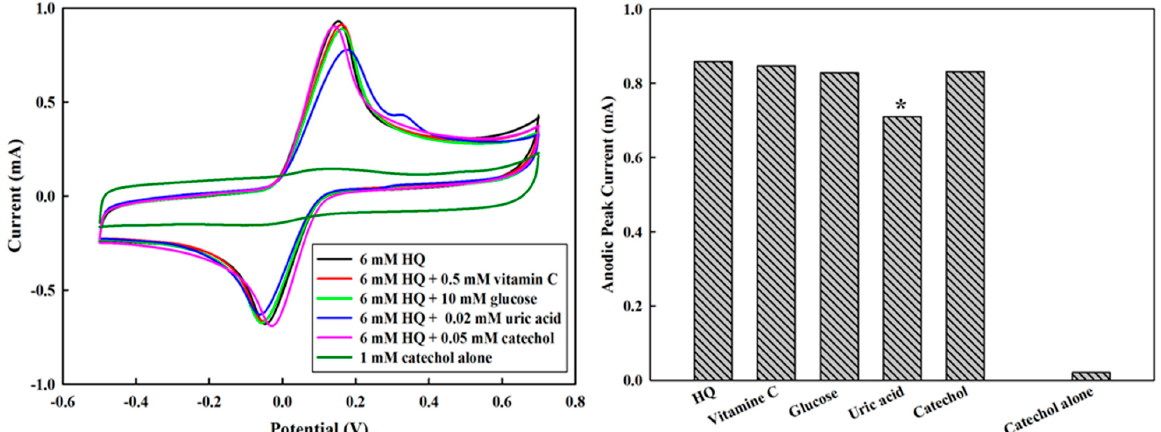
Figure 9. Potential interference on the measurement. ( A ) the cyclic voltammetry profiles for 6 the detection of 6 mM HQ in the presence of vitamin C, glucose, uric acid, and catechol. The potential was swept from − 0.5–0.7 V with the rate of 100 mV s − 1 . ( B ) The influence of interference on the anodic peak currents of CV for 6 mM HQ, where * denotes the significant reduction in comparison with that for HQ only (first bar).